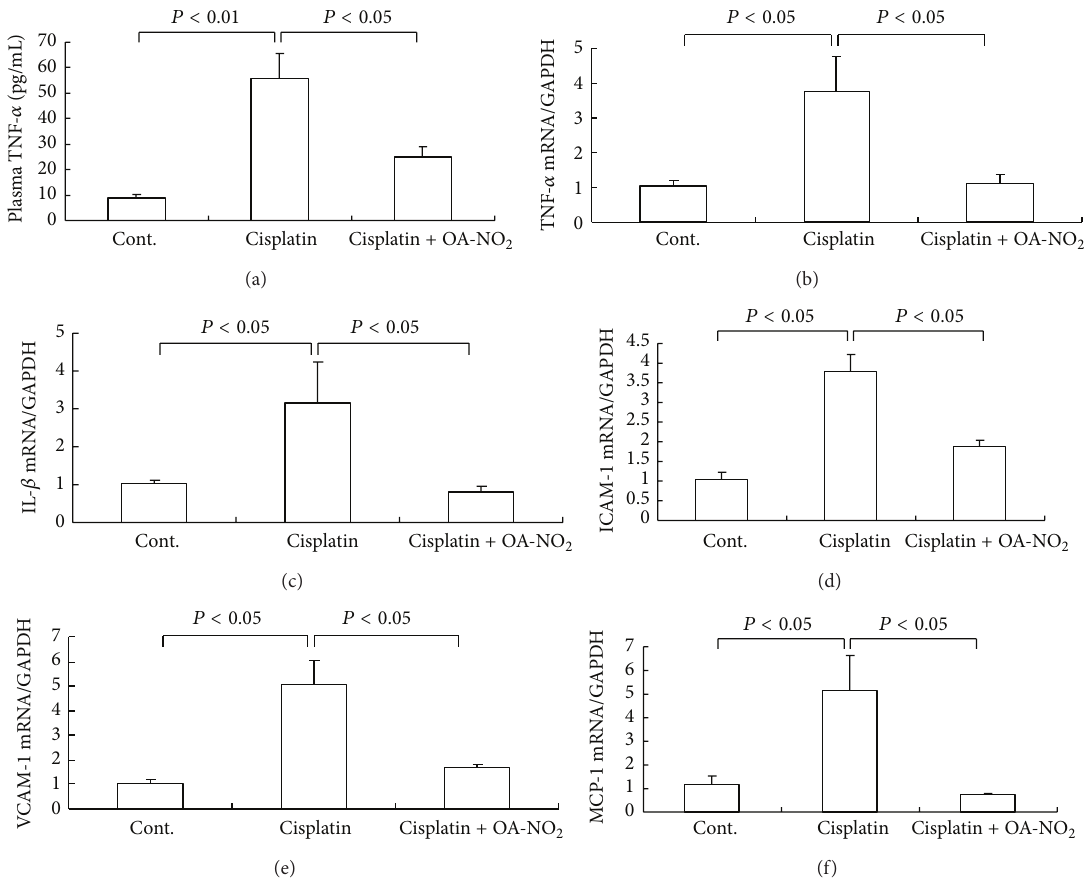
Figure 6: Renal proinflammatory cytokines and adhesion molecules in control, cisplatin vehicle, and cisplatin + OA-NO 2 mice. (a) Enzyme- linked immunosorbent assay analysis of circulating TNF- 𝛼 ; the real-time RT-PCR of renal TNF- 𝛼 mRNA (b), renal IL-1 𝛽 mRNA (c), renal ICAM-1 mRNA (d), renal VCAM-1 mRNA (e), and renal MCP-1 mRNA (f) expression. Cont.: 𝑁 = 6 ; cisplatin: 𝑁 = 12 ; cisplatin + OA-NO 2 : 𝑁 = 13 . Data are mean ±